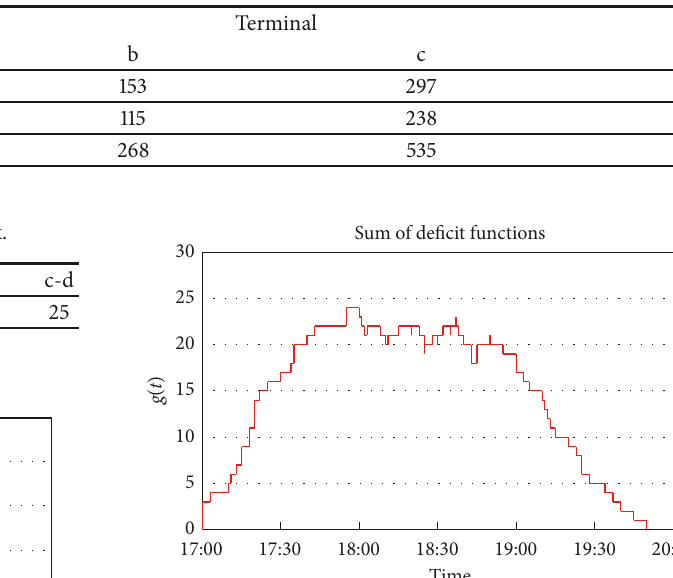
Table 3: Passenger demands at the four terminals.